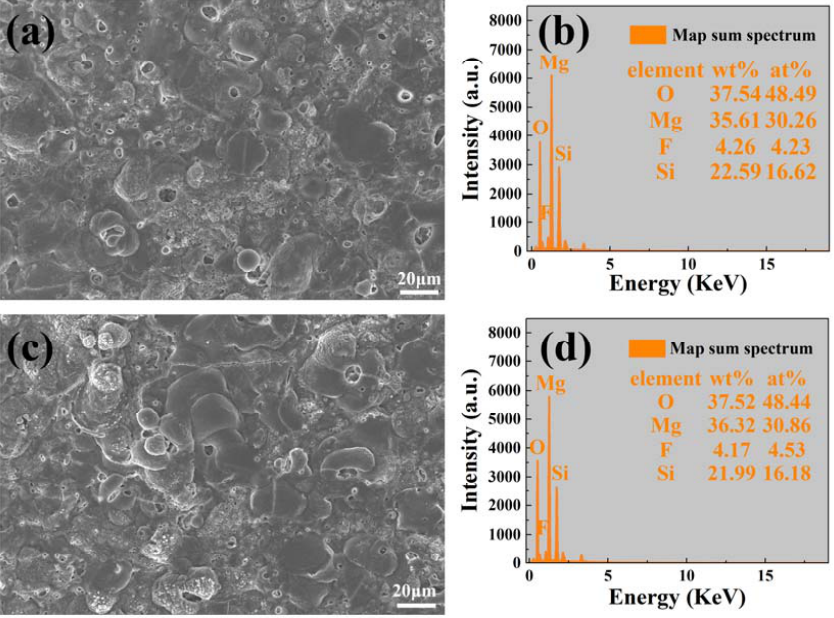
Figure 2. Surface morphology and EDS spectra of micro ‐ arc oxidation (MAO) coatings: ( a , b )